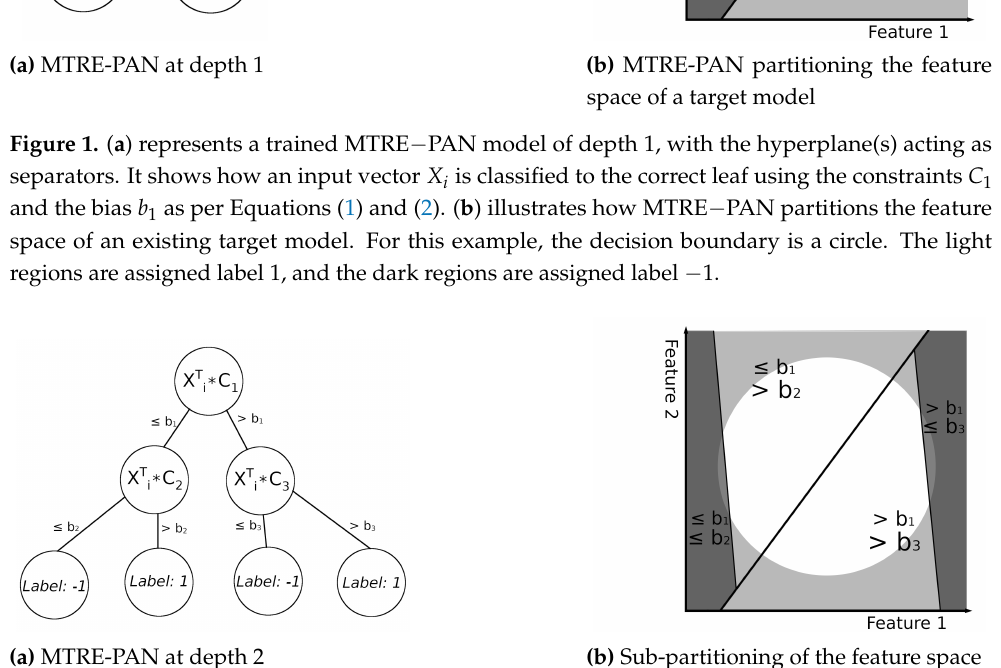
Figure 2. MTRE − PAN is applied to the same target model in Figure 1 with the depth expanded to